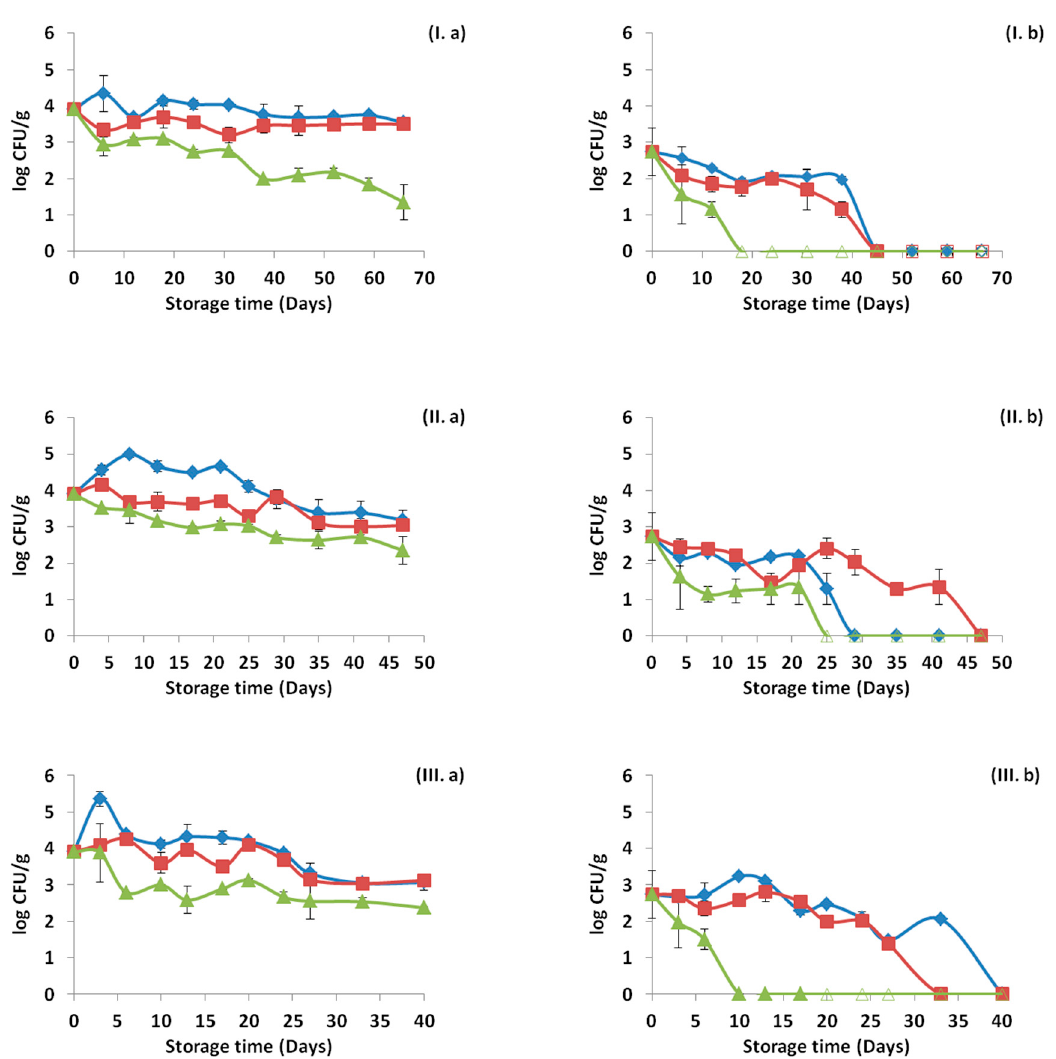
Figure 4. Survival curves of Listeria monocytogenes cocktail strains in ham stored at 4 ◦ C ( I ), 8 ◦ C ( II ) and 12 ◦ C ( III ), without ( a ) and after ( b ) high pressure processing treatment. ( ♦ ) Control samples, ( ■ ) samples with edible film free from oregano essential oil-OEOF and ( ▲ ) samples with edible film supplemented with oregano essential oil-OEOS. Open symbols ( ◊ , □ , Δ ), indicate absence of Listeria monocytogenes after application of the enrichment method. The bars represent the mean values ± standard deviations.